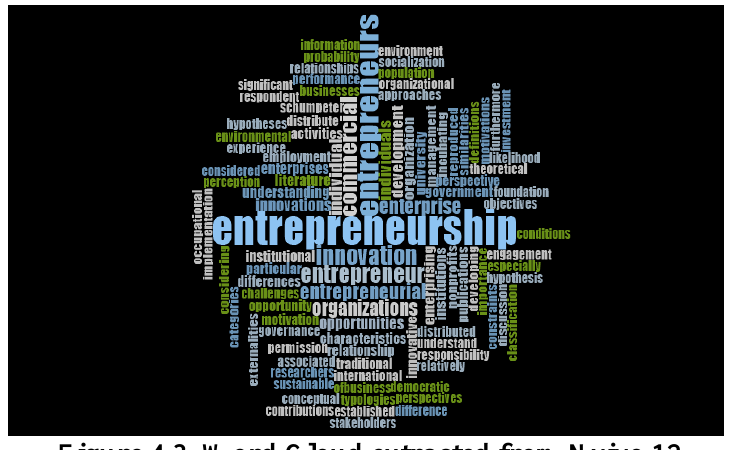
Figure 4.3. Word Cloud extracted from Nvivo 12